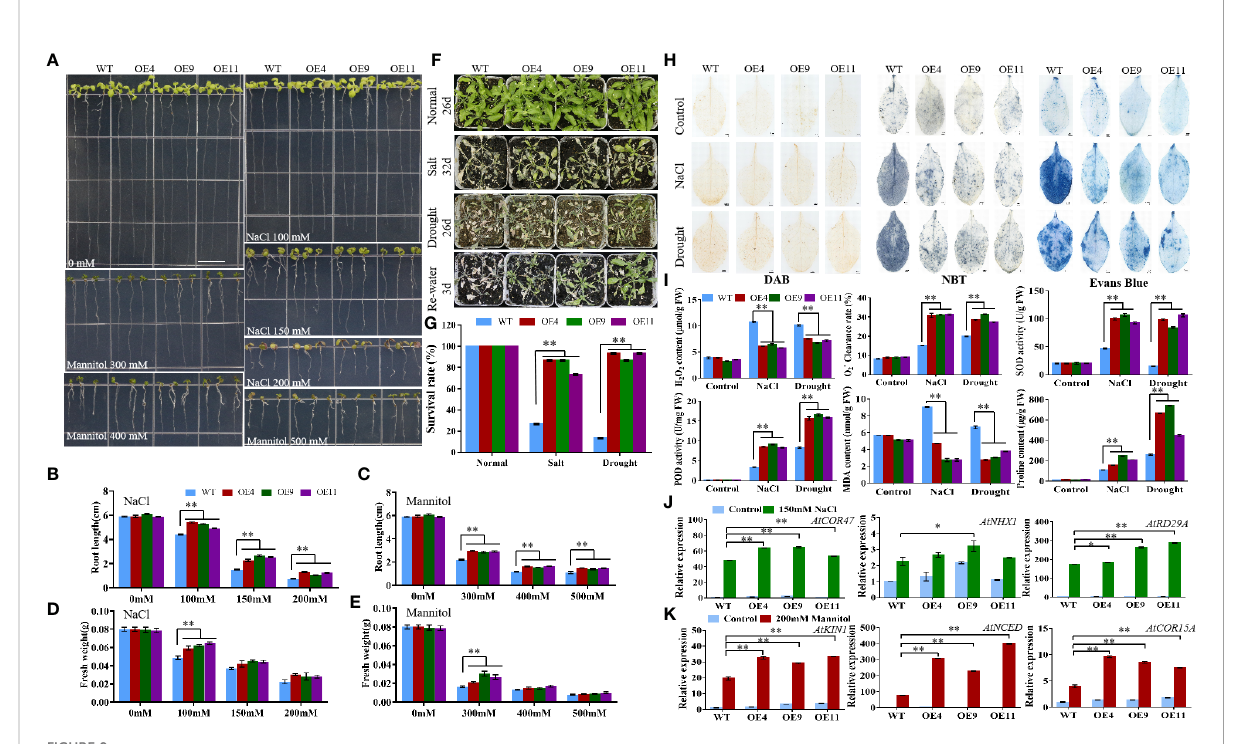
FIGURE 9 Analysis of MiCOL9A transgenic lines and WT under different stress treatments. (A) Phenotype. The bars represent 1.0 cm. (B, C) Root length and (D, E) fresh weight under NaCl and mannitol conditions. (F) Phenotypes. Normal, control; salt, 300 mM NaCl; drought, withholding of water. (G) Survival rate. (H) DAB, NBT and Evans Blue staining. (I) H 2 O 2 content, O − 2 clearance rate, SOD activity, POD activity, MDA content and proline content. (J, K) Expression pattern of stress-related genes. Blue, before treatment; green, 150 mM NaCl (J) ; red, 200 mM mannitol (K) . Signi fi cant differences were assessed at p < 0.05 (*) and p < 0.01 (**) levels by Student ’ s t